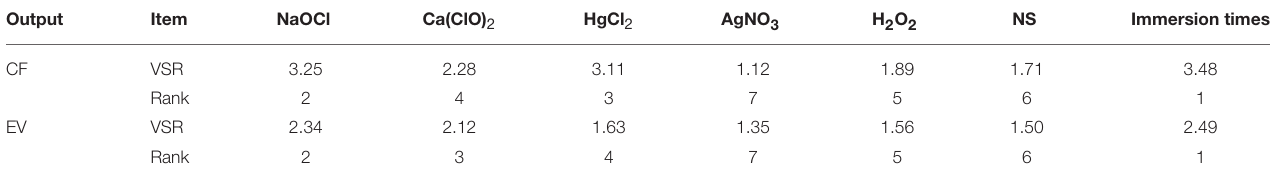
TABLE 9 | Importance of inputs for contamination frequency (CF) and explant viability (EV) of chrysanthemum according to sensitivity analysis on the developed MLP model to rank the importance of inputs.